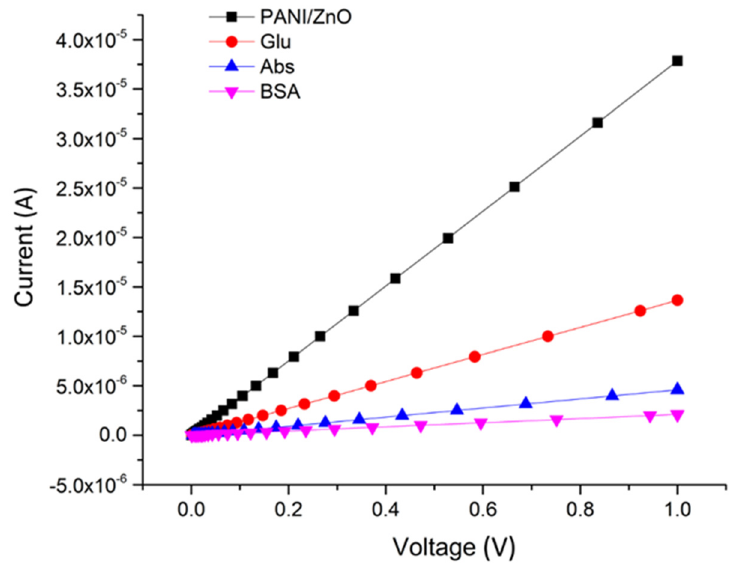
Figure 4. I-V sweep plot for each step of gold electrode modification.